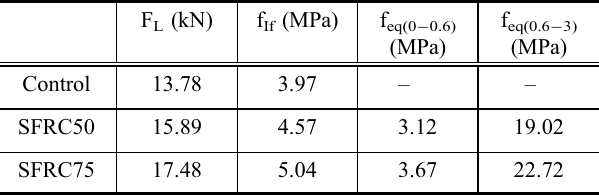
Table 3 Strength values as per UNI